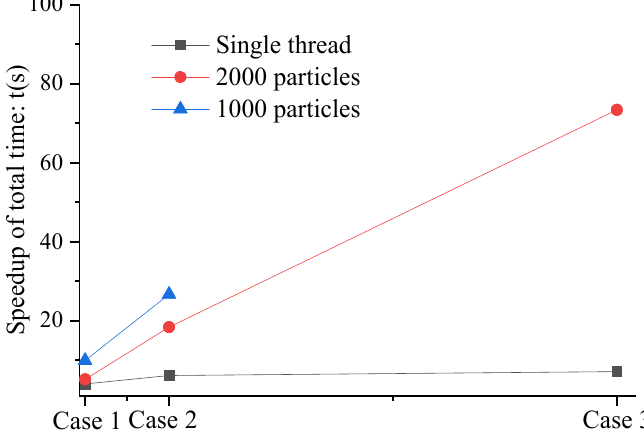
Figure 9. Speedup of total runtime for validation 1. CPU-OpenMP allocated a thread according to 1000 fluid particles in parallel and calculated case 2 and case 3, in 26.7 s and 91.36 s,